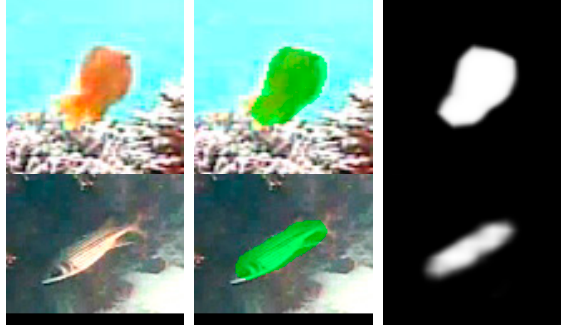
Figure 12. Results of the fish4knowledge project data set on the model M1.